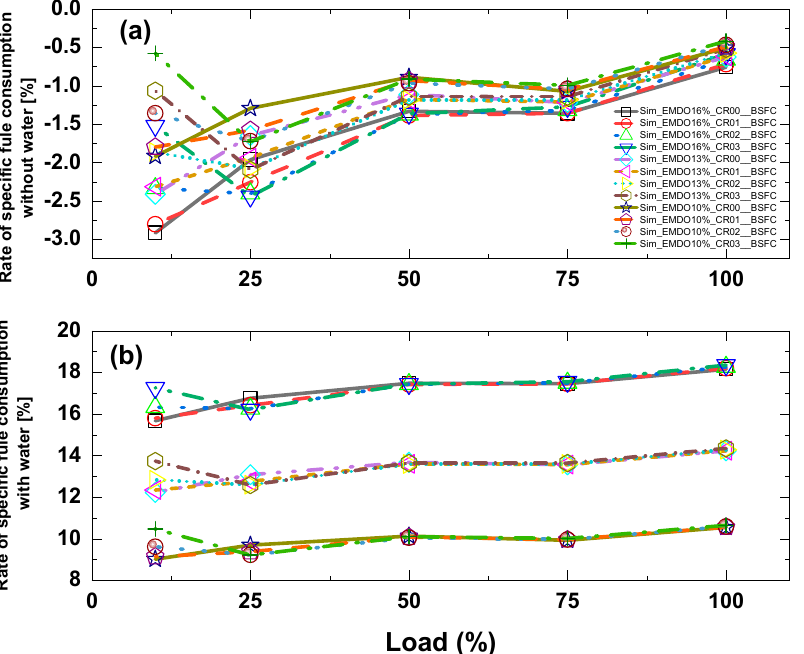
Figure 14. Characteristics of the variation rate of Specific Fuel C on sumption (SFC) versus the conditions—without water ( a ) and with water ( b ).